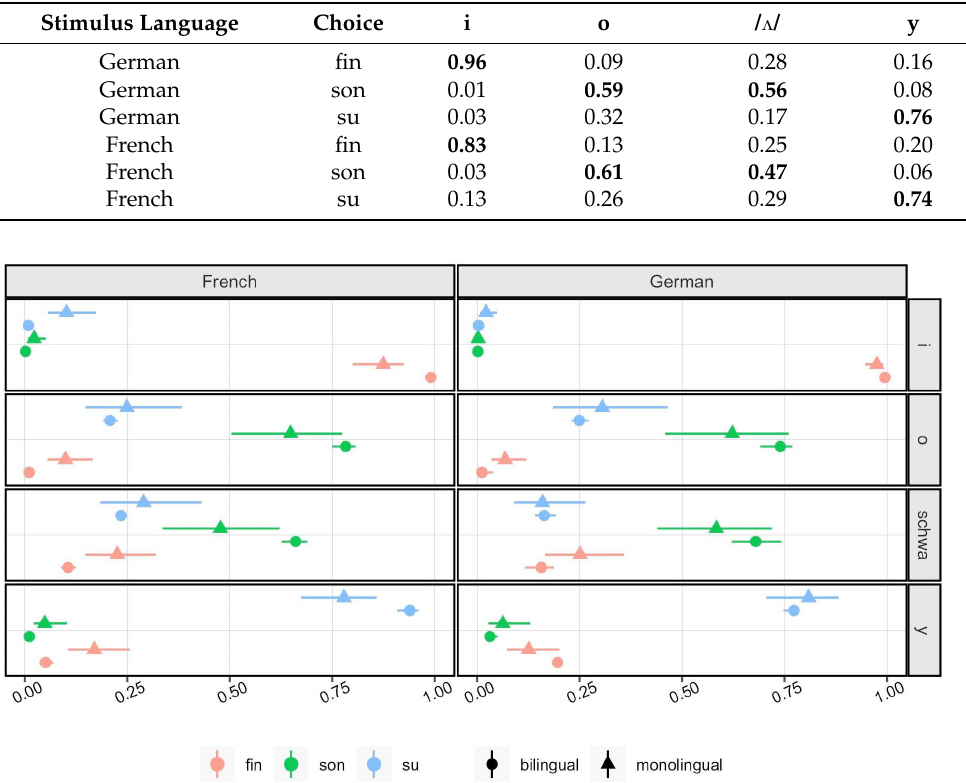
Table 7. The percentage of categorizations of phonemes in the Spanish monolinguals group.